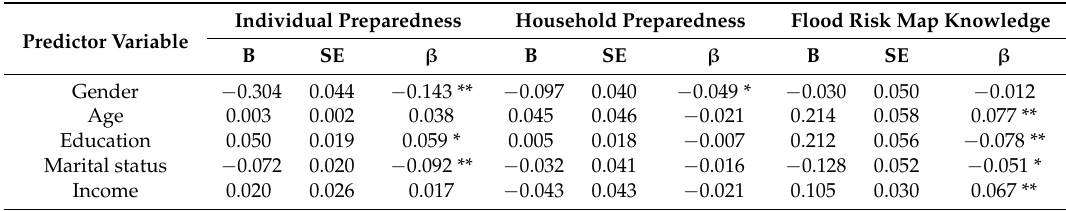
Table 3. Results of a multivariate regression analysis concerning individual and household preparedness and flood risk map knowledge ( n =